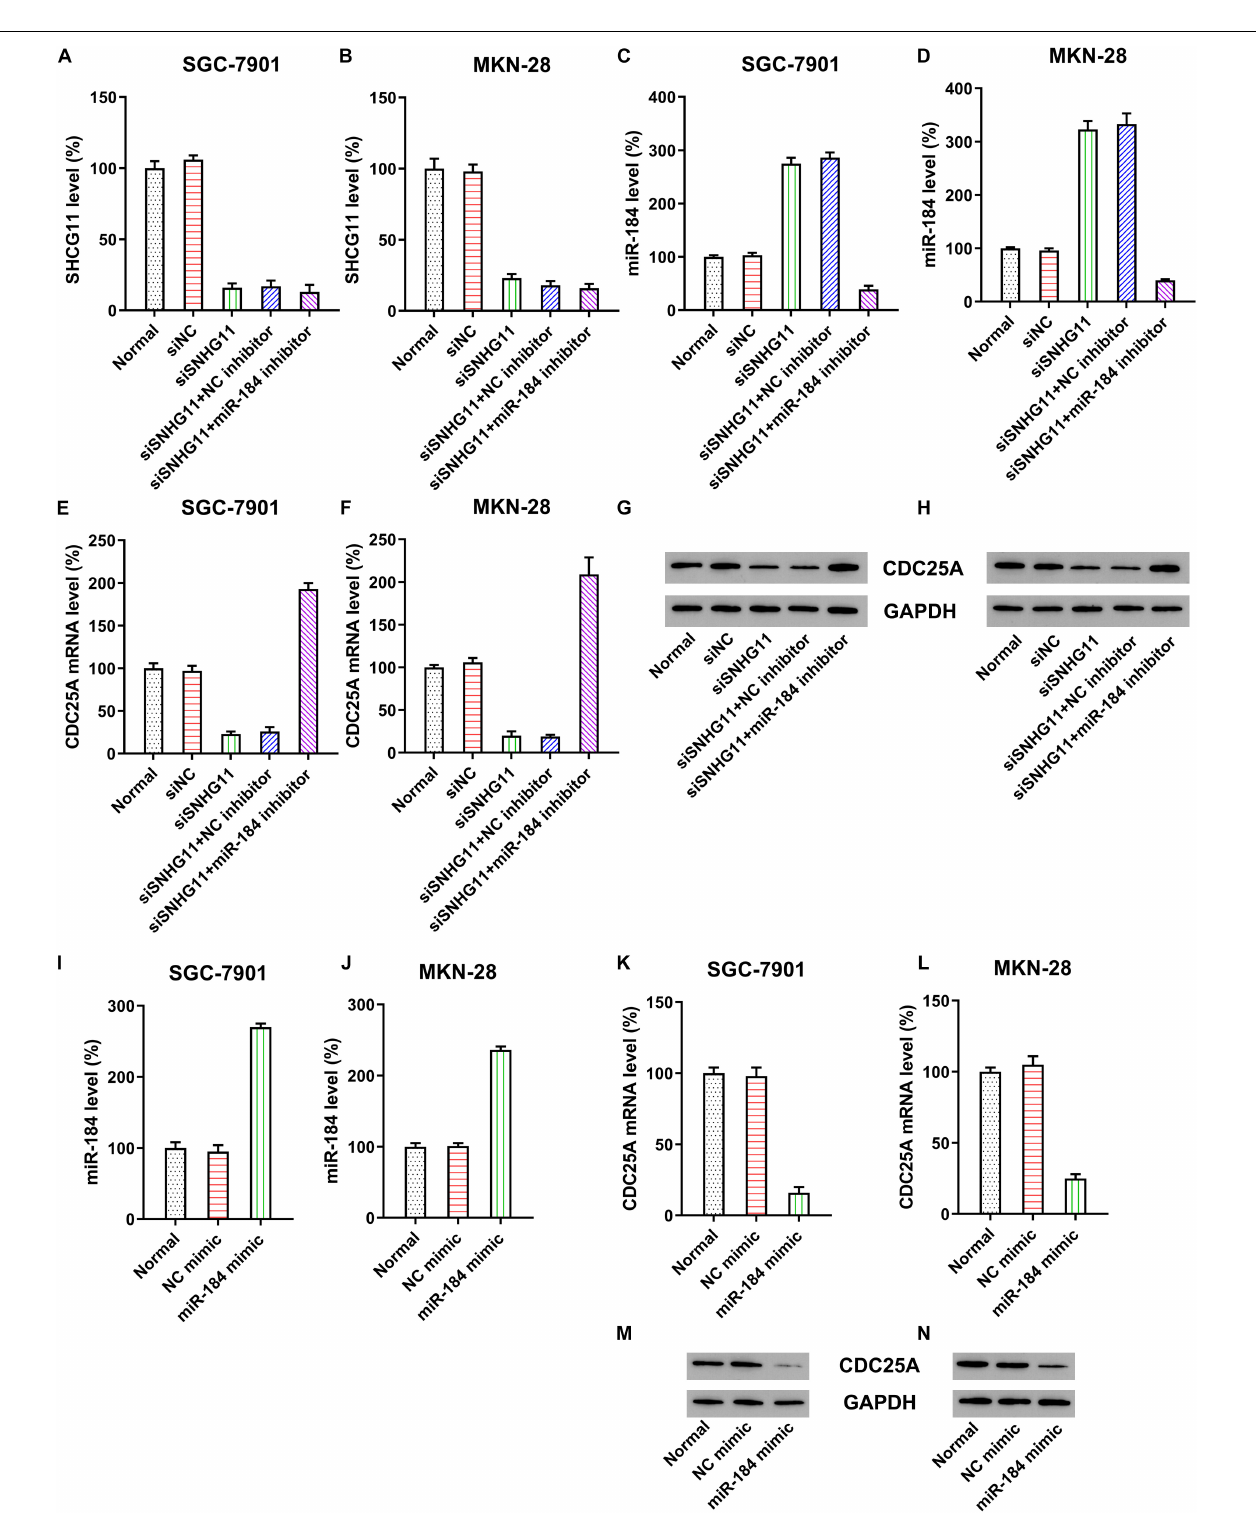
FIGURE 3 | The correlation of SNHG11, miR-184, and CDC25A expression in MKN-28 and SGC-7901 cells. MKN-28 and SGC-7901 cells were subjected to NC shRNA, SNHG11 shRNA, SNHG11 shRNA + NC inhibitor, SNHG11 shRNA + miR-184 inhibitor for 36 h. qPCR assays were used to indicate the expression of (A,B) SNHG11, (C,D) miR-184, and (E,F) CDC25A mRNA in cells. (G,H) Western blotting analysis was conducted to indicate the CDC25A protein expression in cells treated with NC mimic, miR-184 mimic for 36 h, or not. qPCR assays were used to indicate the expression of (I,J) miR-184, (K,L) CDC25A mRNA in cells. (M,N) Western blotting analysis was conducted to indicate the CDC25A protein expression in cells. “Normal” represents non-transfected cells.